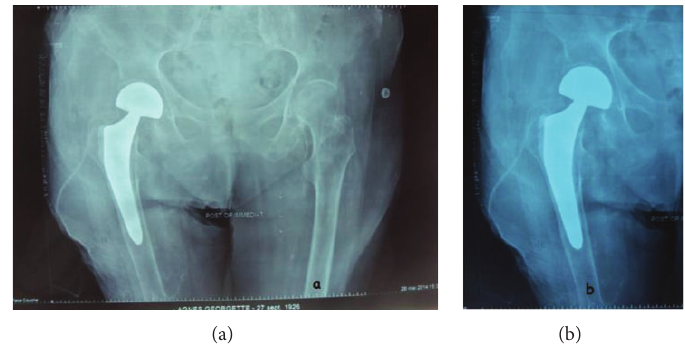
Figure 5: Postoperative radiography with uncemented bipolar hemiarthroplasty.